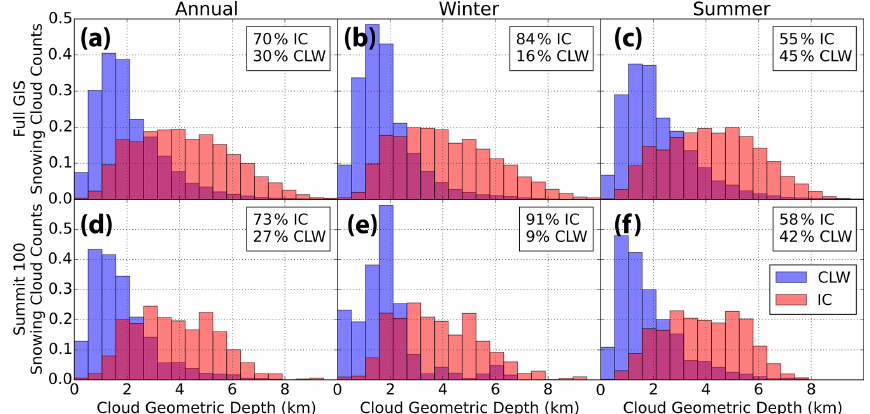
Figure 11. Histograms of precipitation regime geometric cloud depth. Red bins contain all footprints of IC snowfall, and blue bins contain all footprints of CLW snowfall for each given season (annual, winter, and summer) and region (full GrIS, summit 100) as described in Fig. 6. The histograms are normalized to highlight the distribution differences. The relative percentage of each regime is listed in the top right of each panel.